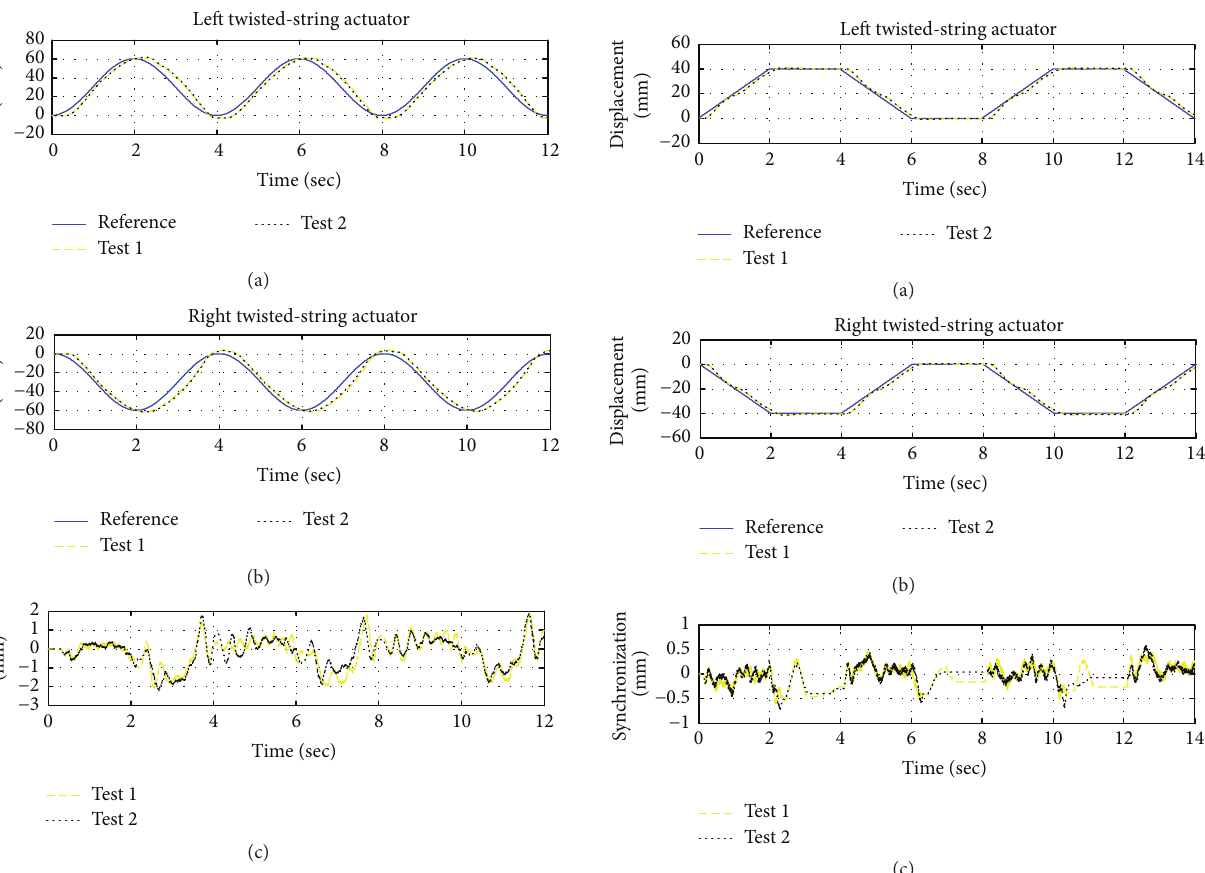
Figure 11: Experimental outcome of PID-FC controller (sinusoidal motion): (a) comparison between reference trajectory and actual trajectories of left actuator; (b) comparison between reference tra- jectory and actual trajectories of right actuator; (c) synchronization errors between left and right twisted actuators.